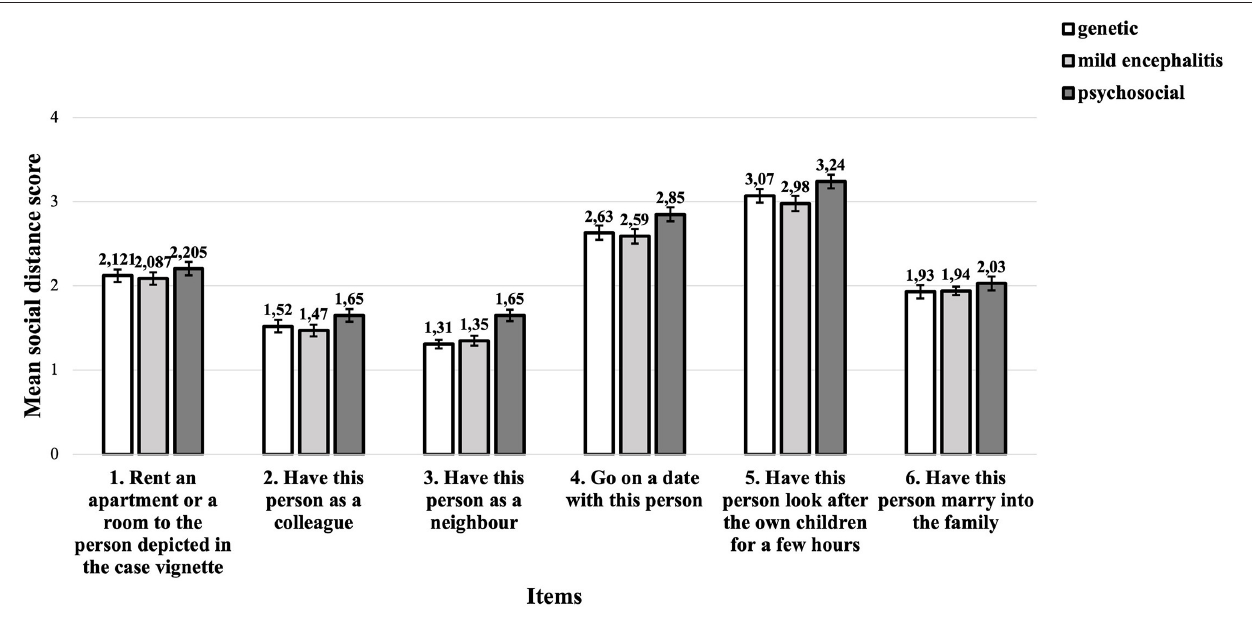
Frontiers in Psychiatry |